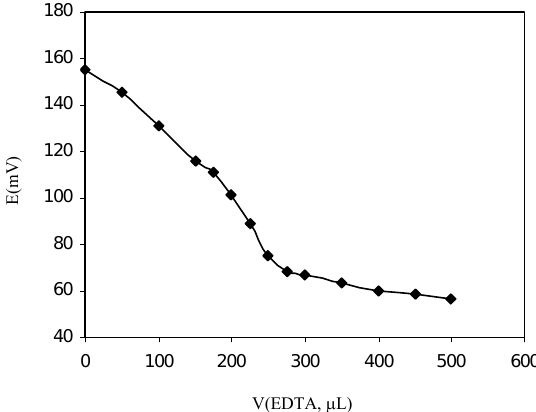
Figure 5. Potential titration curve of 25.0 mL from a 1.0 × 10 -4 mol L -1 Eu 3+ solution with Table 3. Determination of Eu 3+ in water samples solutions using the constructed sensor